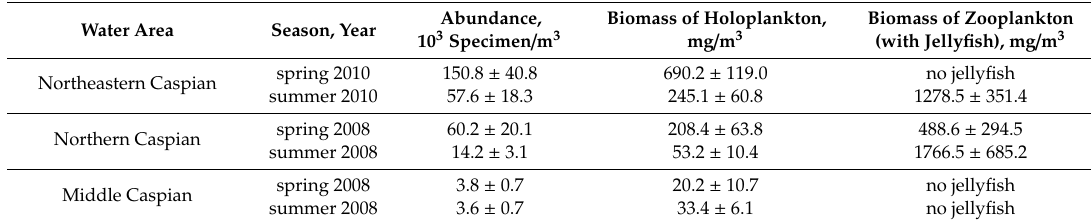
Table 3. Quantitative variables of zooplankton communities in the surveyed water area of the Caspian Sea (mean with standard error).